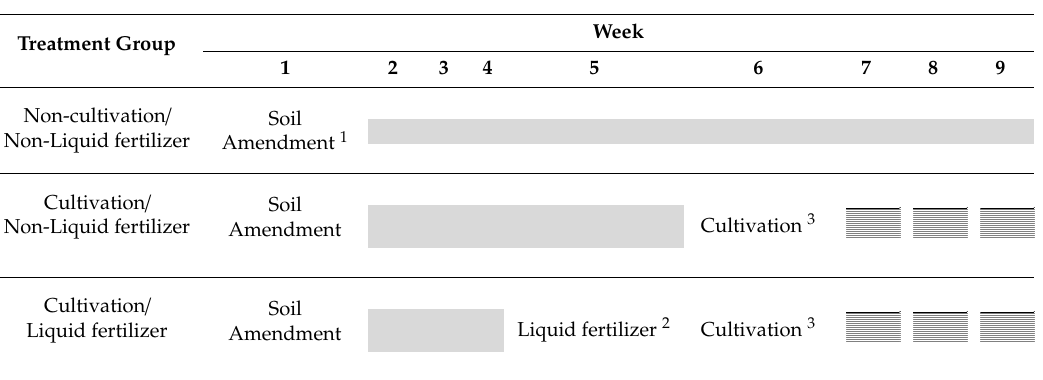
Table 1. Experimental design and process.